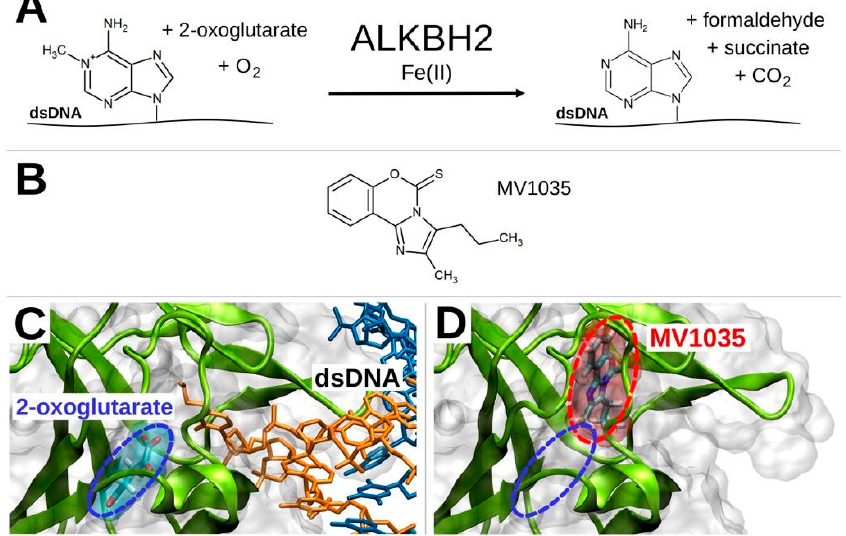
Figure 2. ALKBH2 enzymatic reaction and competitive inhibition hypothesis. The enzymatic reaction ( A ) catalyzed by ALKBH2 is reported along with the 2D formula of MV1035 ( B ). The positions of 2-oxoglutarate ( C ) and MV1035 ( D ) within their corresponding binding sites are also reported, as obtained by X-ray diffraction (PDB code: 3BU0) and SPILLO-PBSS calculation, respectively. The partial overlapping between the binding sites of 2-oxoglutarate and MV1035 is shown, which implies a competition between the two molecules for the same binding region that leads to an inhibition of the catalytic activity of ALKBH2 (drawings rendered using VMD [30]).